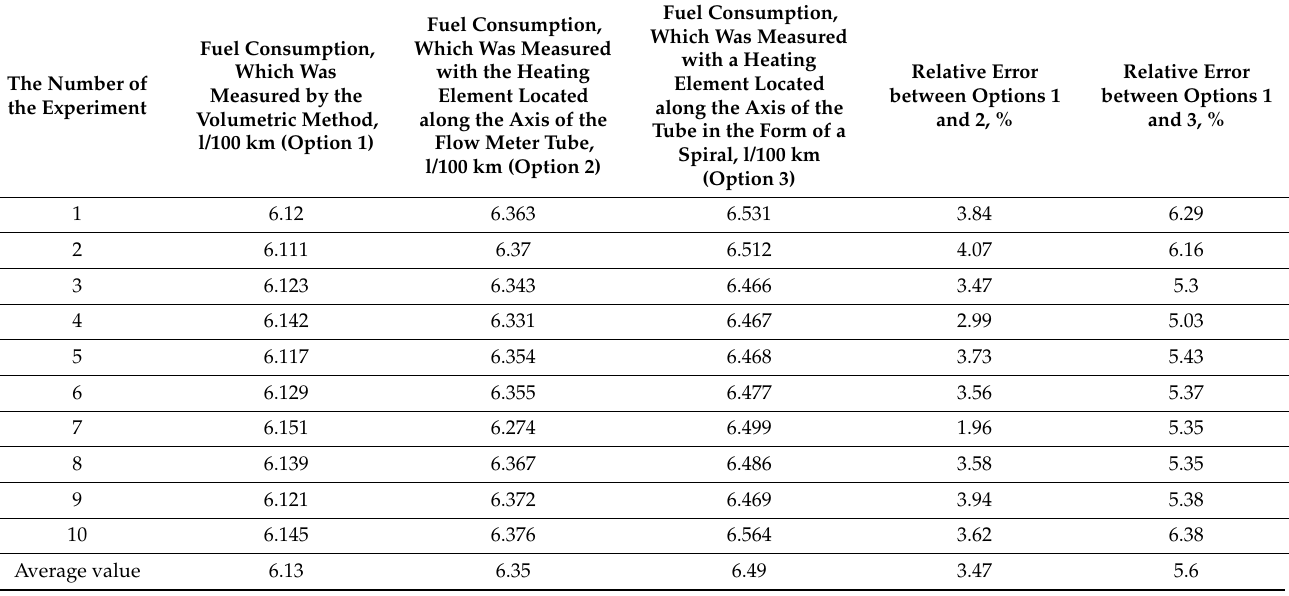
Table 4. Determination of fuel consumption by volumetric method and using a thermal flowmeter with heating elements of different shapes.